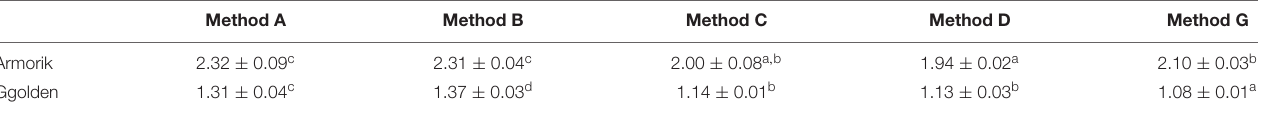
TABLE 4 | A comparison between TPC of the flavonoids extracted from Ggolden and Armorik with the different extraction